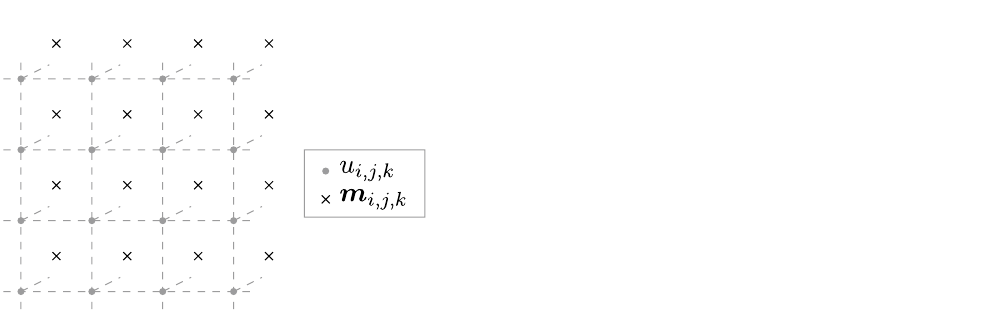
Figure 3. Finite difference grid used for the discretization of u and div ( m ) (on vertices) as well as m and h (on cell